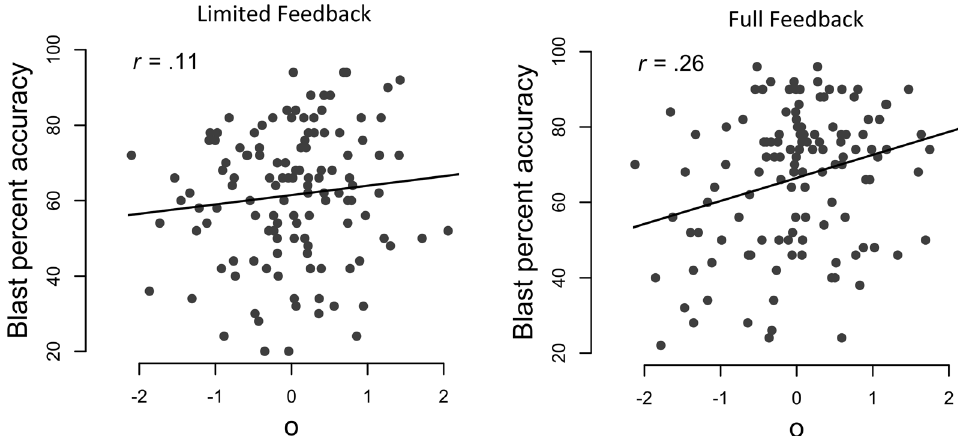
Fig. 3 Correlation between o and percent accuracy on the Blast